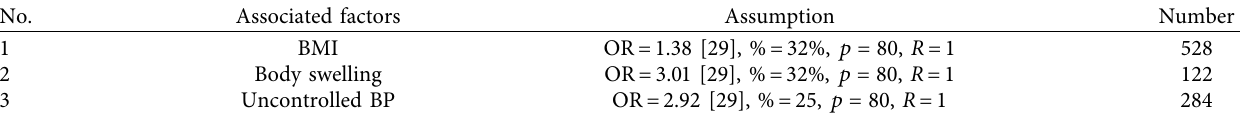
Table 1: Sample size calculation using associated